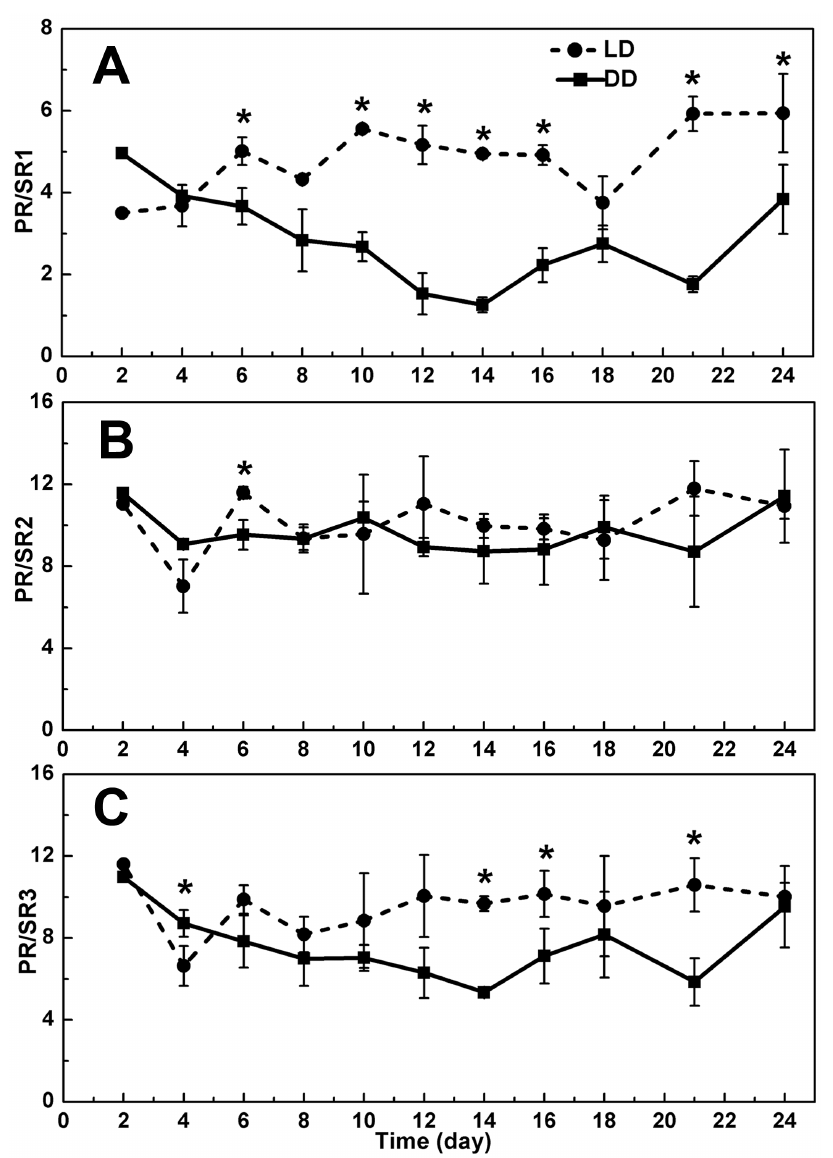
Fig. 5. Ratio of expression levels between proton-pump rhodopsin (PR) and sensory rhodopsins (SR1, SR2 and SR3). LD, cultures grown under light: dark cycle; DD, cultures grown under continuous darkness; error bars, standard deviation. (A) PR/SR1; (B) PR/SR2; (C) PR/SR3. Significant differences between LD and DD groups were marked with ‘‘*’’.